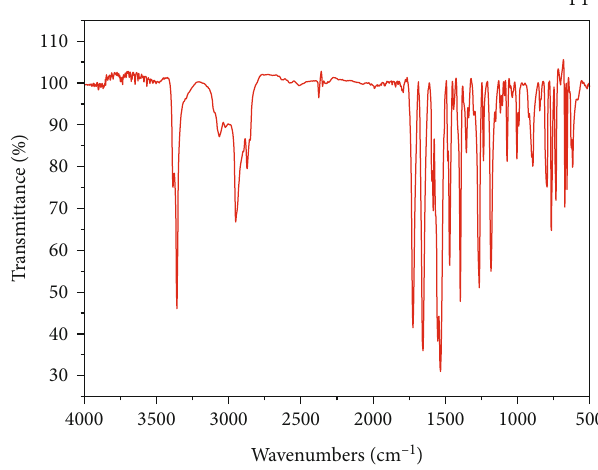
, bromodecane, and xylene). 4